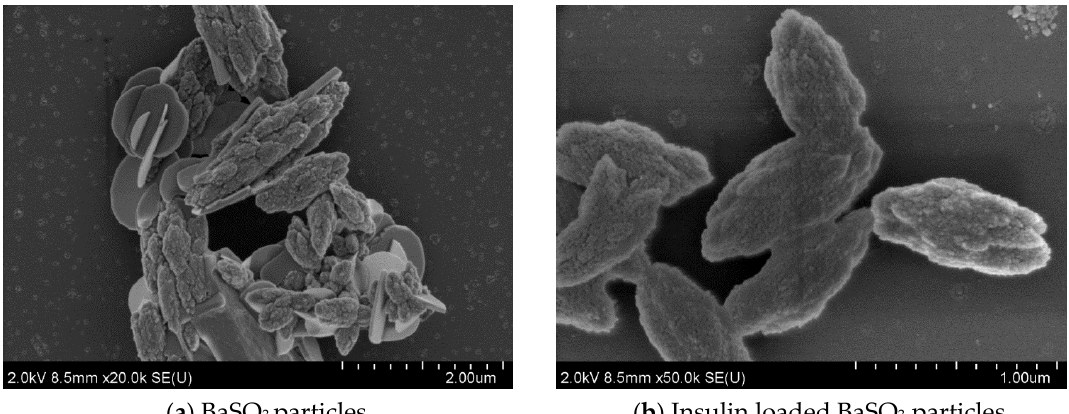
Figure 9. Images of empty and insulin-loaded BaSO 3 particles. ( a ) Empty BaSO 3 particles look more aggregated. ( b ) Insulin-loaded BaSO 3 particles prepared with 50 µg of insulin form distinctive oval-shaped separate clusters. Pictures were taken at 2.0 kV.